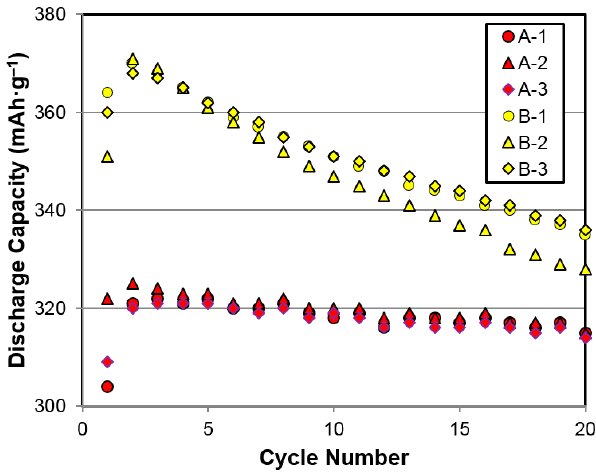
Figure 4. Half-cell capacities measured using the three-electrode cell setup for annealed alloys A and B. Table 3. Gaseous phase and electrochemical hydrogen storage properties of annealed alloys A and B. Reversible H- Plateau PCT Alloy Full H-Storage Storage Pressure Annealed alloy B